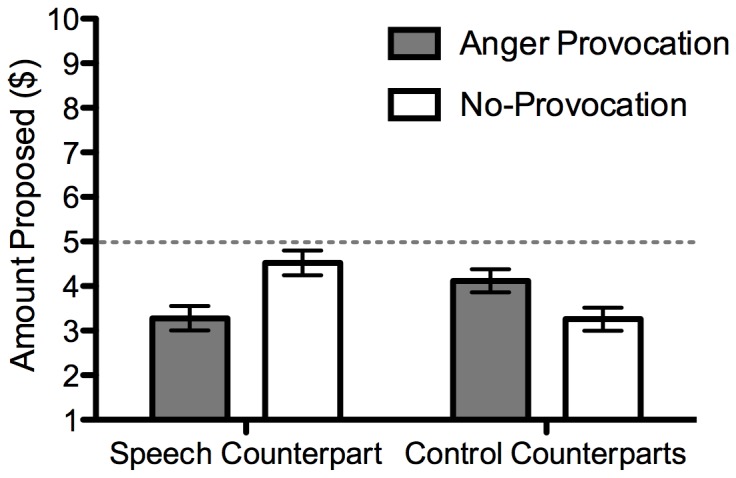
Amount proposed as a function of provocation condition and counterpart type.Error bars display SEM. The dotted line at $5 represents a fair offer.